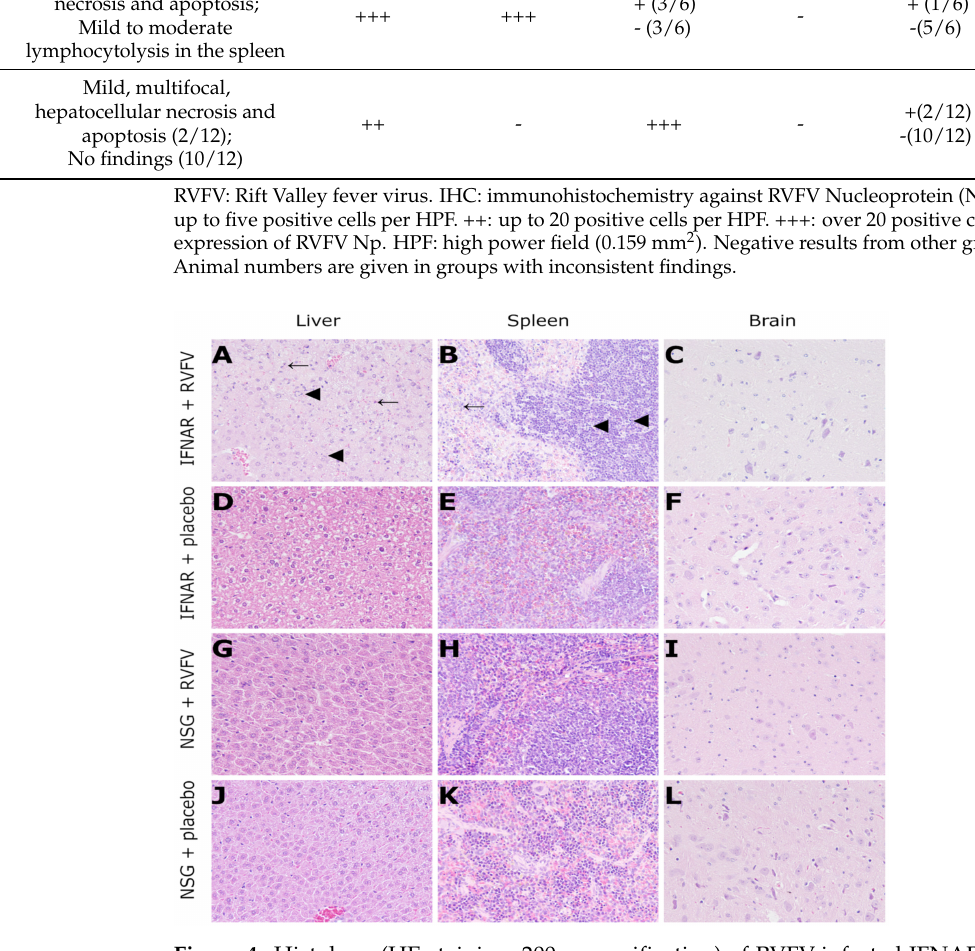
Figure 4. Histology (HE staining, 200x magnification) of RVFV-infected IFNAR mice (3 dpi) and NSG mice (14 dpi): IFNAR mice exhibit severe, multifocal to coalescing hepatocellular necrosis (arrowheads, ( A )) and apoptosis (arrows, ( A )) as well as mild lymphocytolysis in the white pulp (arrowheads, ( B )) and moderate, multifocal necrosis in the red pulp of the spleen (arrow, ( B )). No lesions were observed in the brain ( C ) and placebo-infected control mice ( D – F ). Likewise, no lesions were present in the majority of RVFV-infected ( G – I ) or any placebo ( J – L ) NSG mice. RVFV: Rift Valley fever virus; dpi: days post infection; IFNAR: B6-IFNAR tmAgt mice. NSG; NOD.Cg-Prkdc scid Il2rg tm1WjI /SzJ